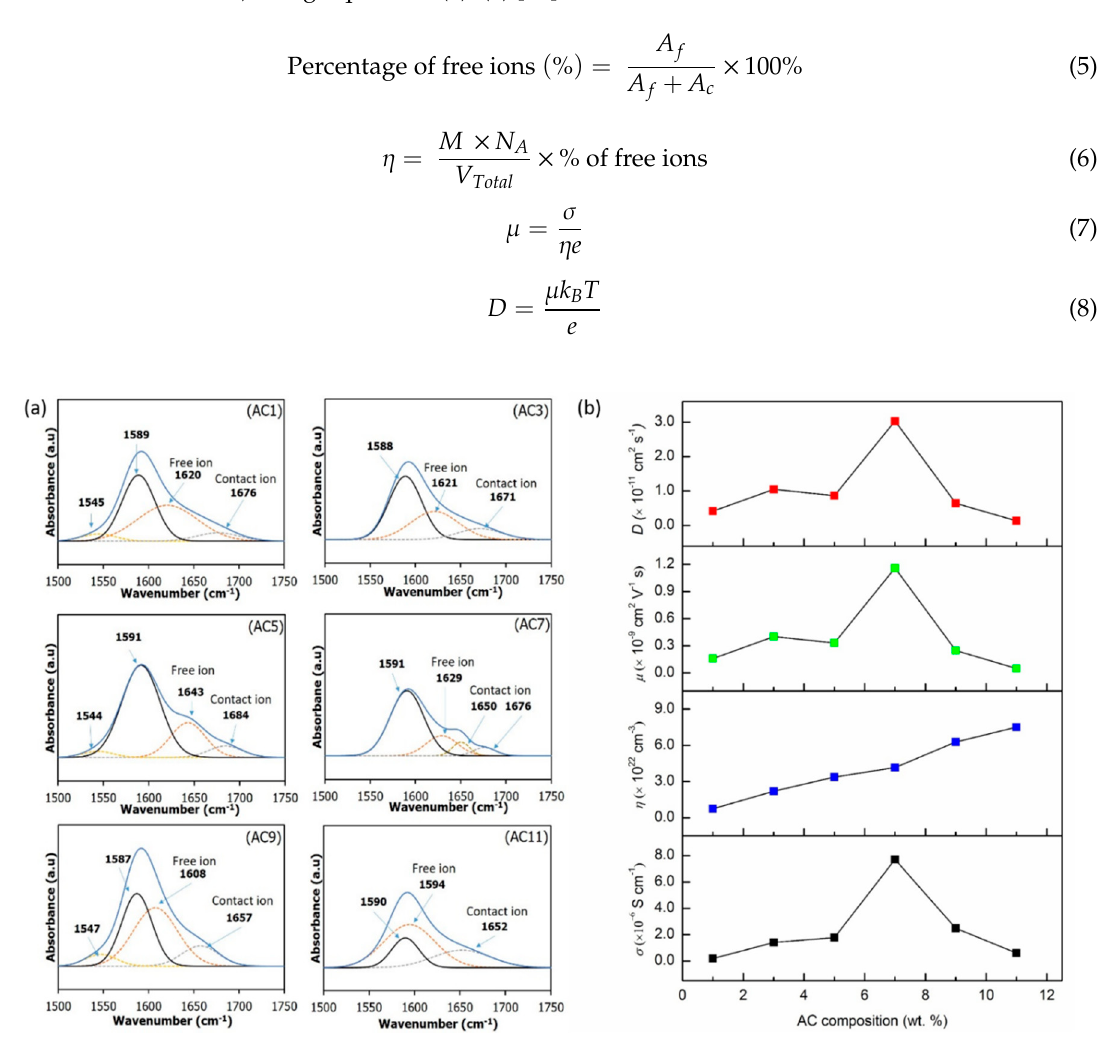
Figure 4. ( a ) The de-convoluted spectra of each sample and ( b ) the plot of respective transport parameters in CMC-AC biopolymer film.